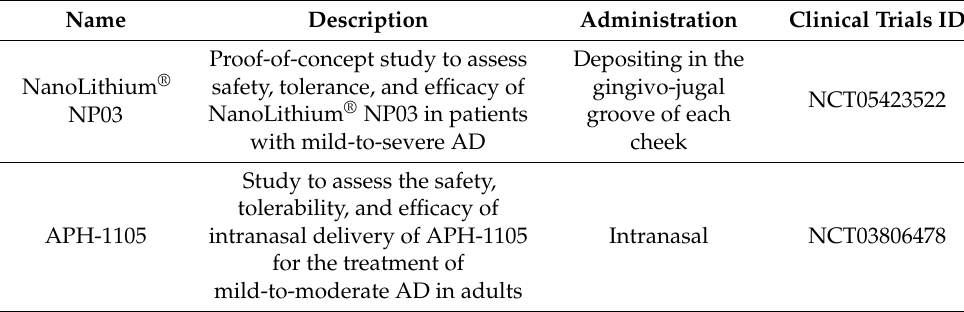
Table 4. Clinical status of